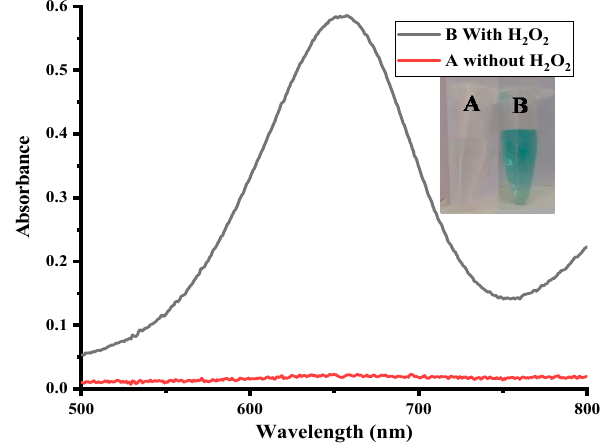
Figure 6. Absorbance spectra conditions 50 µL Co/CeO2/C/IL nanocomposite, 500 µL of PBS (pH 7), 85 µL of H 2 O 2 (6 mM), and 180 µL of TMB (10 mM). ( A ) In the absence of H 2 O 2 and ( B ) in the presence of H 2 O 2 .